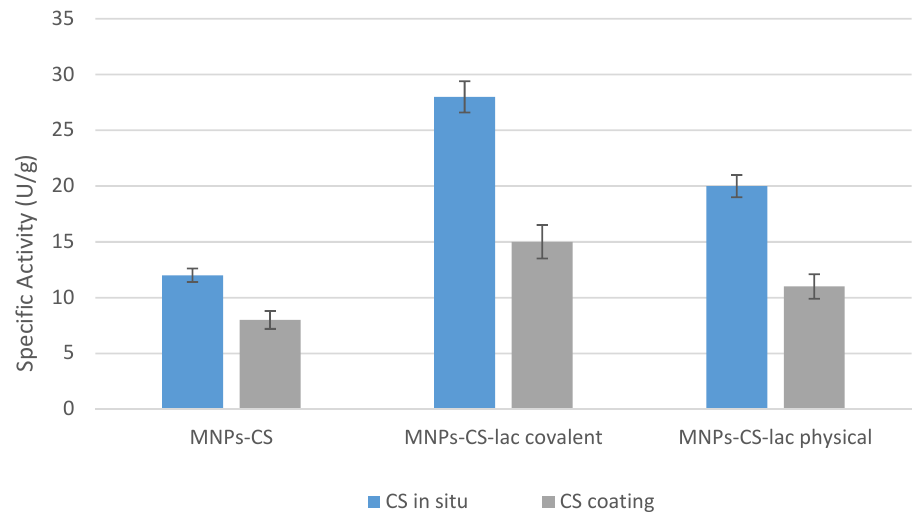
Figure 5. Specific activity of the two MNPs-CS systems containing covalently and physically immobilized laccase compared with that of the MNPs-CS system without enzymes.